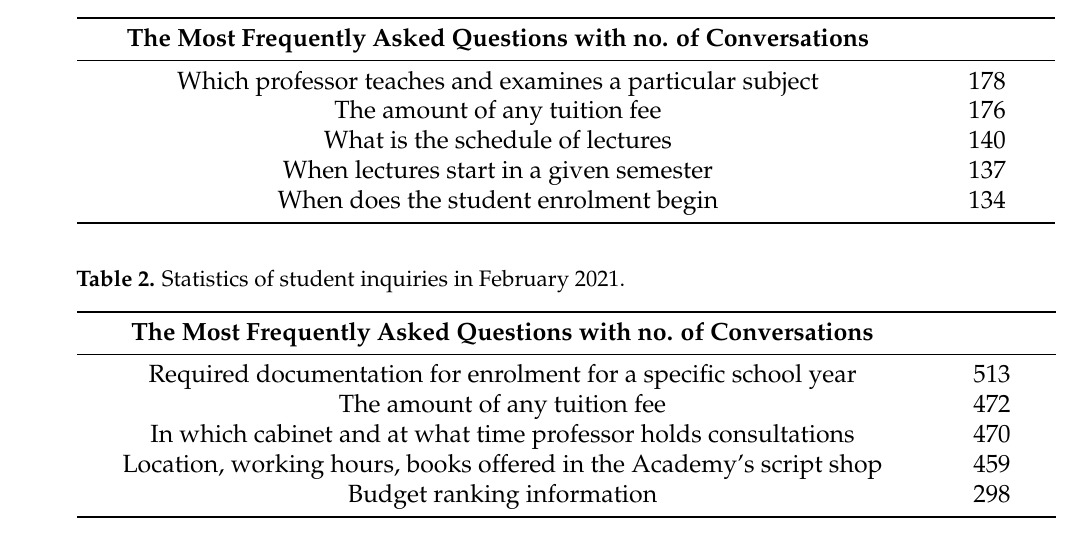
Table 1. Statistics of student inquiries in January 2021.